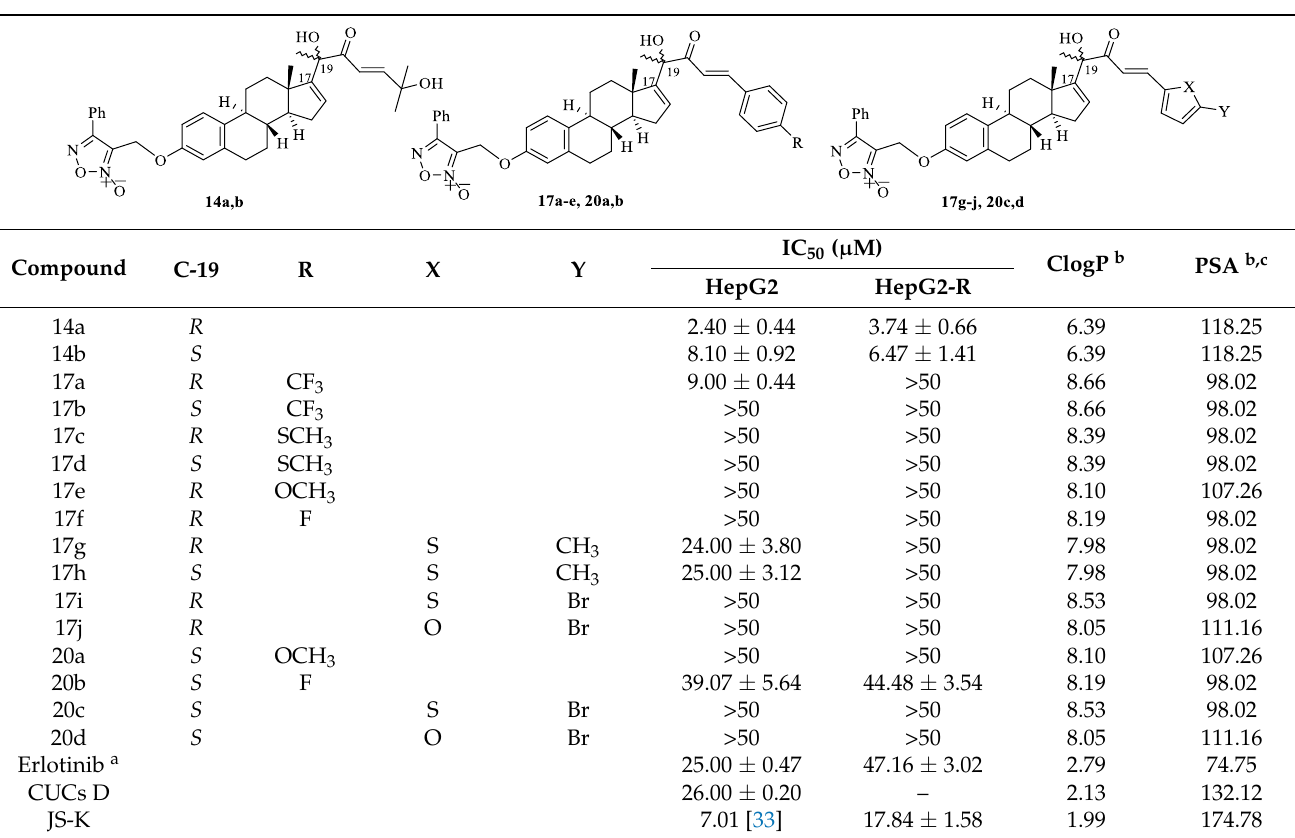
Table 2. Anticancer activity of the NO- ∆ -16-CIEA 14a , b , 17a – j , and 20a – d in human cancer cell lines.